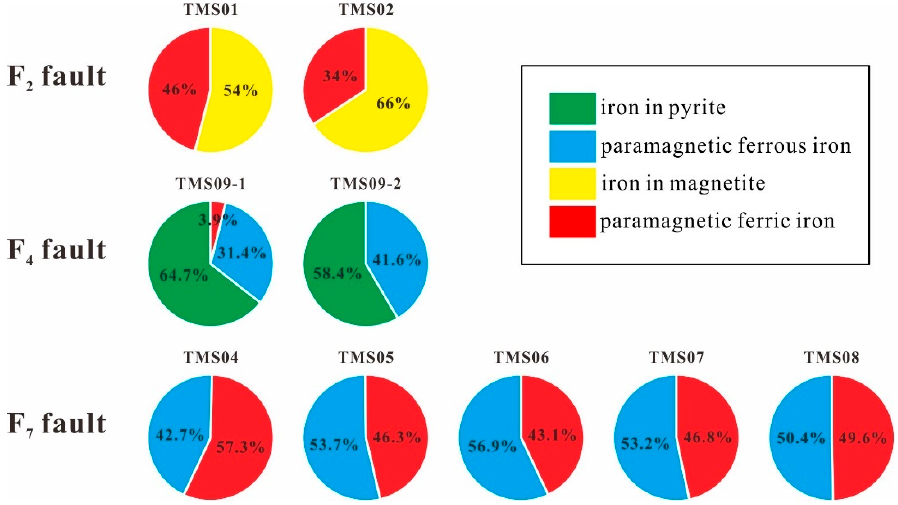
Figure 4. Relative content of iron species in fault gouge and host rock in the Tamusu